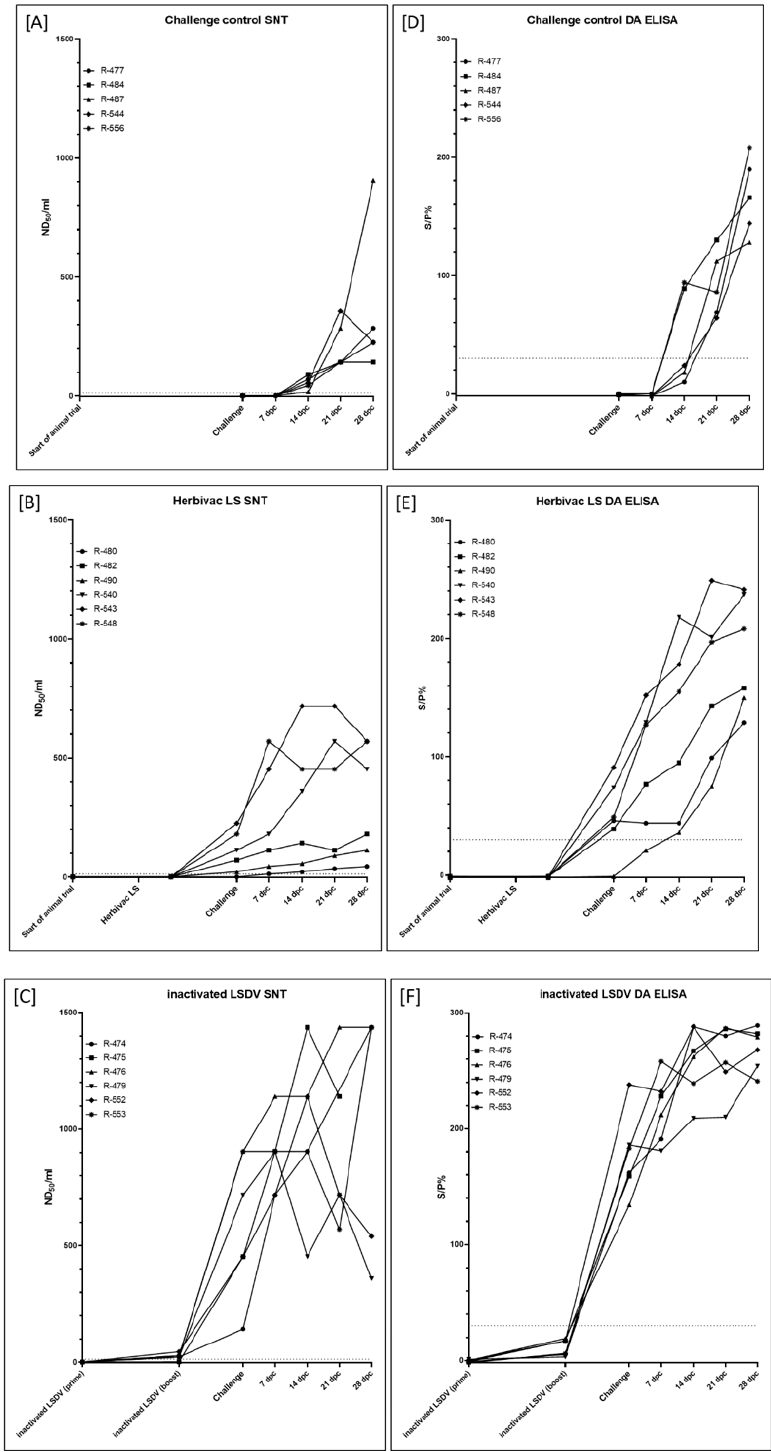
Figure 6. Seroconversion of the cattle of the proof-of-concept animal trial. Serum samples taken at certain time points during the study were analyzed using ( A – C ) the serum neutralization test (SNT) and ( D – F ) the DA ELISA. ( A + D ) Cattle of Group 1A were left unvaccinated and served as challenge control group. ( B + E ) Cattle of Group 1B received the commercially available life-attenuated vaccine “Herbivac LS”, and ( C + F ) cattle of Group 1C were vaccinated with an inactivated vaccine prototype on basis of LSDV-“Neethling vaccine” strain. Samples in the SNT were defined positive at ND 50 /mL ≥ 13, whereas in the ELISA samples with S/P% ≥ 30 are